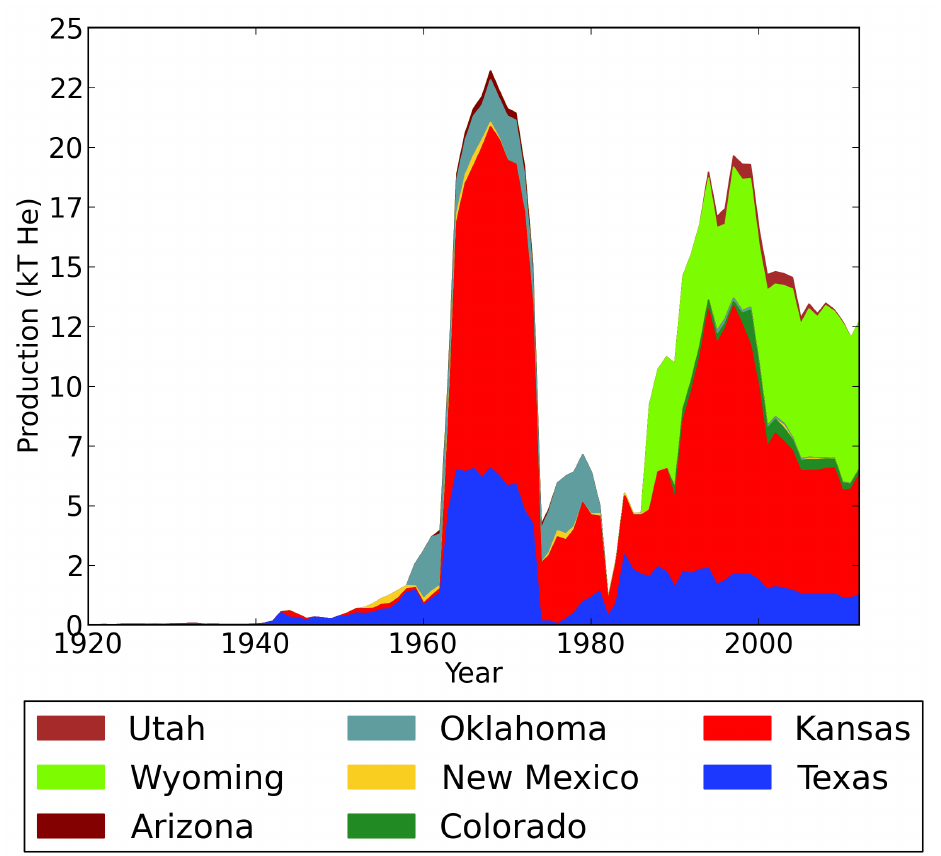
Figure 3. Helium production in the USA by